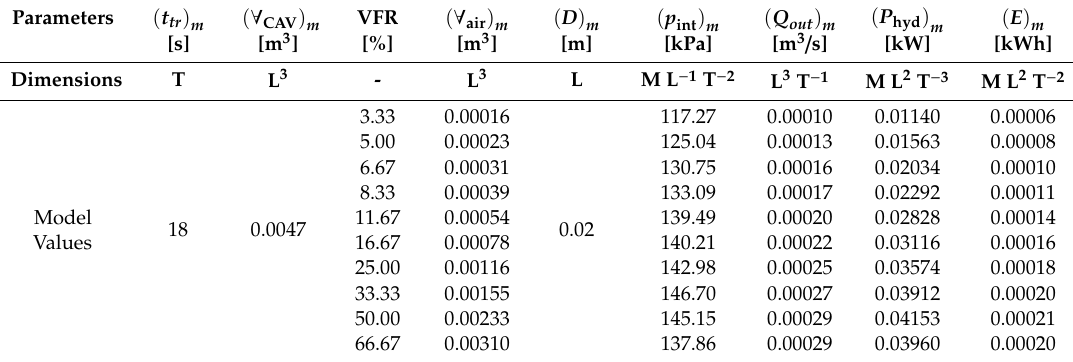
Table 3. Measured and calculated parameters in the laboratory model apparatus for di ff erent VFRs. Parameters